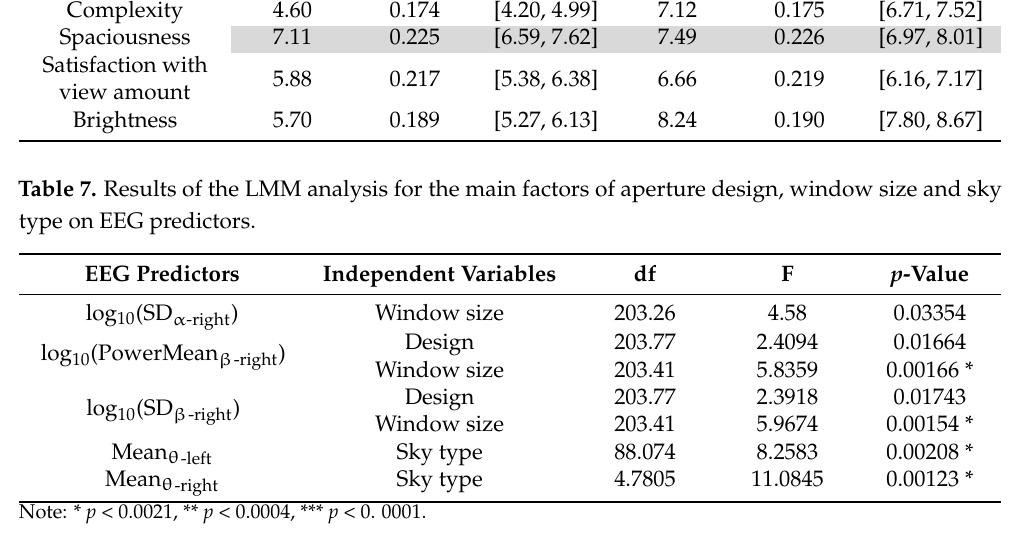
Table 8. Estimated marginal means (EMM), standard errors (SE) and 95% confidence intervals (CI) per EEG attribute and window size (without interaction).